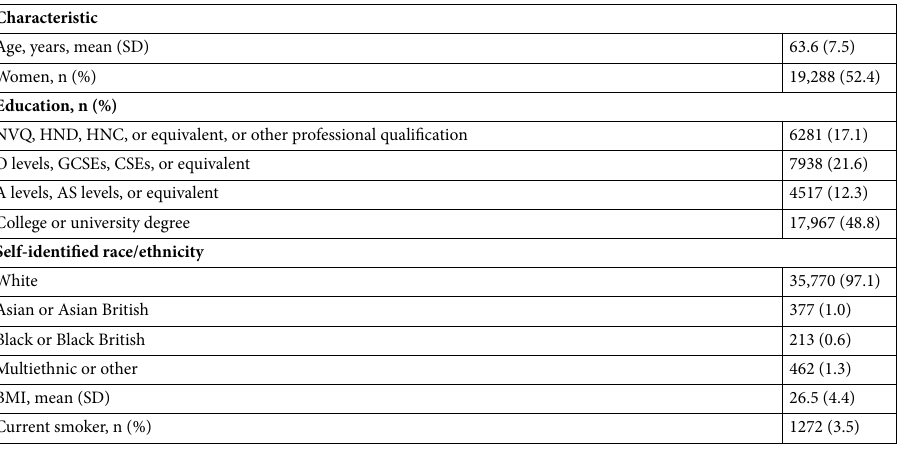
Table 1. Characteristics of UK Biobank participants with available data for primary study analyses (n = 36,822). SD standard deviation, n sample size, NVQ national vocational qualification, HND higher